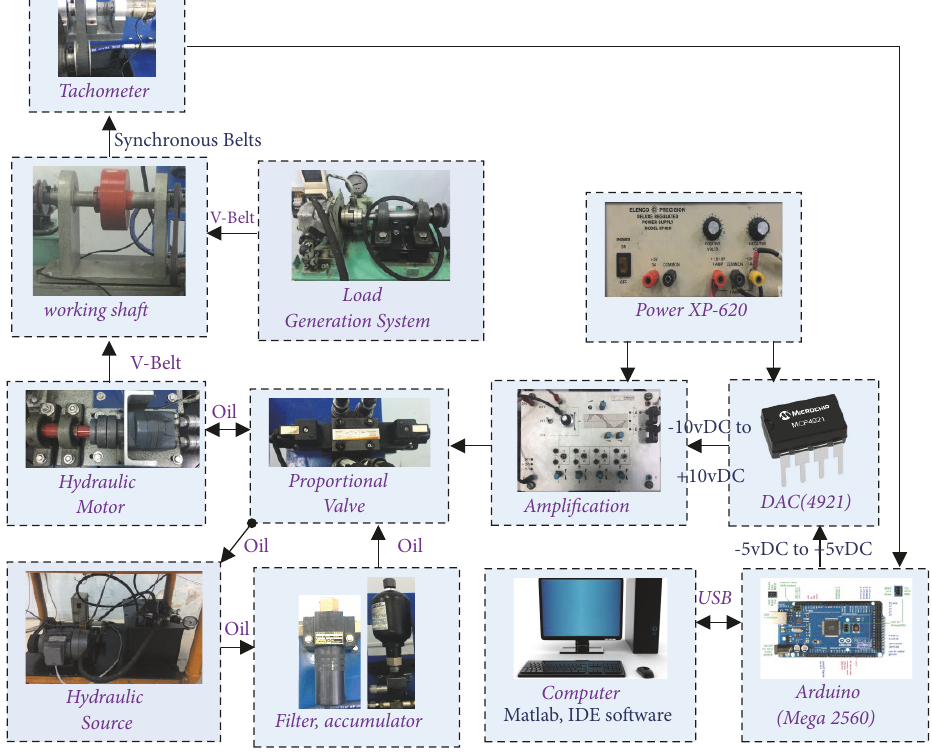
Figure 10: Control block diagram.